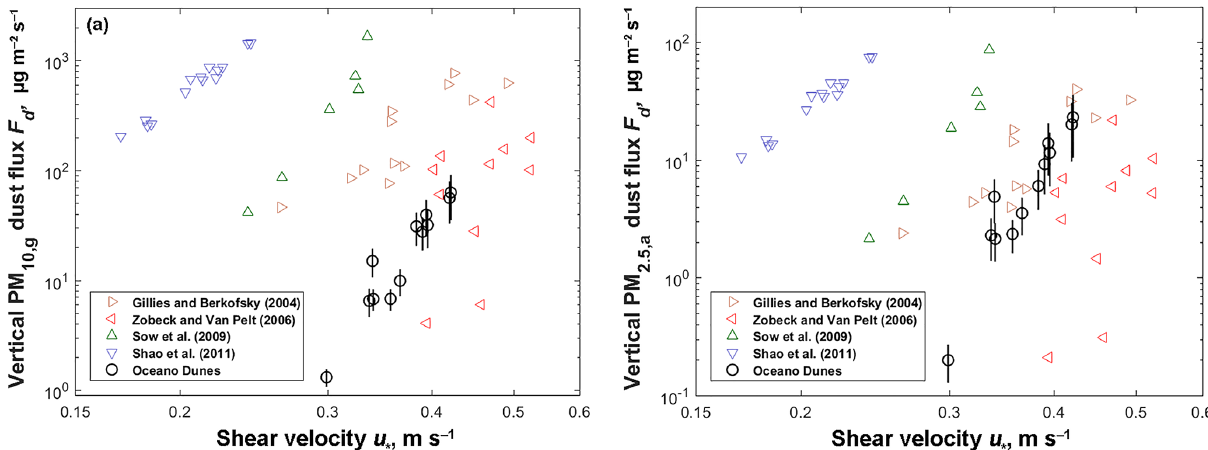
Figure 2. The vertical dust mass flux as a function of shear velocity within (a) the PM 10 , g geometric diameter range and (b) the PM 2 . 5 , a aerodynamic diameter range. Each of the two plots includes measurements at Oceano (black open circles) and previously published field studies of natural dust emissions from non-sandy soils (open triangles). These latter measurements were compiled in Kok et al. (2014a), which corrected these measurements to the PM 10 , g geometric diameter range following the procedure described in that work. Furthermore, we corrected these measurements to the PM 2 . 5 , a aerodynamic diameter range assuming that their PSDs follow the prediction of the brittle fragmentation theory generated by aggregate fragmentation (Kok, 2011). Error bars on the Oceano measurements were obtained through error propagation (details in Supplement). Table 2. Averaged mineralogy of the Oceano Dunes sand samples in unit of percentage by mass, determined from X-ray powder diffraction (XRPD) analysis. Note that the values in the table are averages of mineralogy of four 1g samples with two collected from the tower location and two from 100m upwind. Each analyzed sample contains hundreds of grains. Quartz Potassium feldspar Sodium-rich Clay (microcline and plagioclase minerals orthoclase) feldspar (albite) (illite) Oceano Dunes 51 23 23